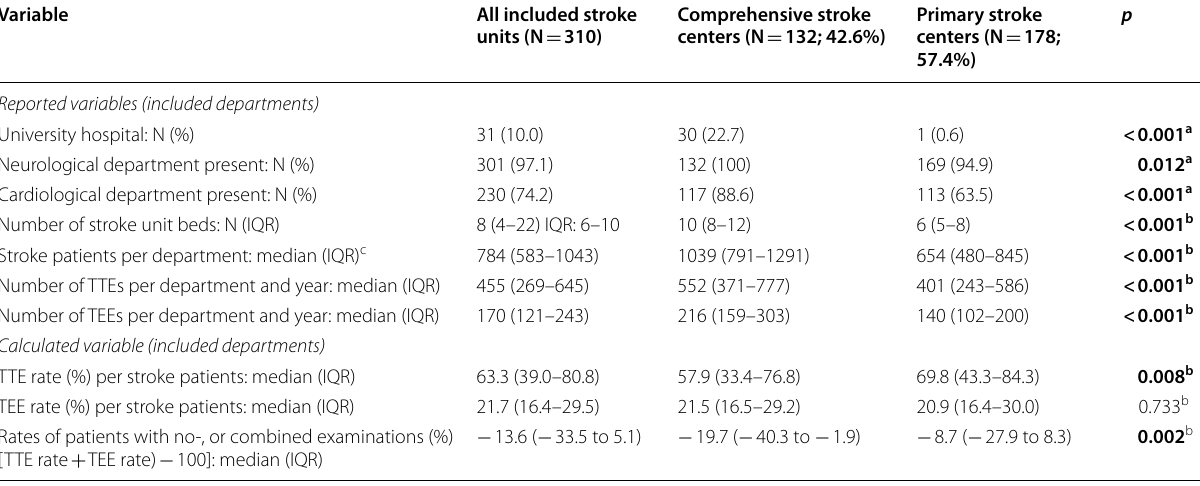
Table 1 Reported and calculated variables of all included departments, with regard to the type of stroke units and respective